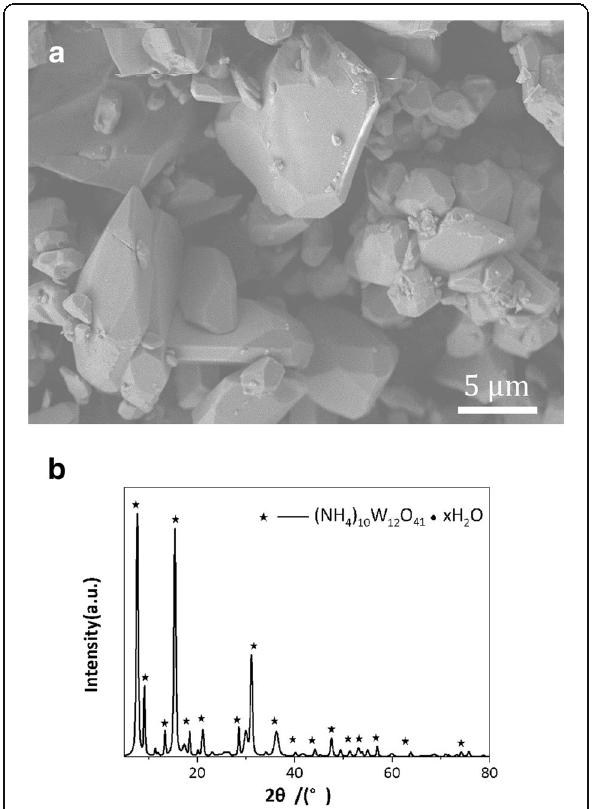
Fig. 1 The microstructure ( a ) and XRD pattern ( b ) of commercially available (NH 4 ) 6 W 7 O 24 ·6H 2 O powders, or ( a ) the microstructure of commercially available (NH 4 ) 6 W 7 O 24 ·6H 2 O powders, and ( b ) the XRD pattern commercially available (NH 4 ) 6 W 7 O 24 ·6H 2 O